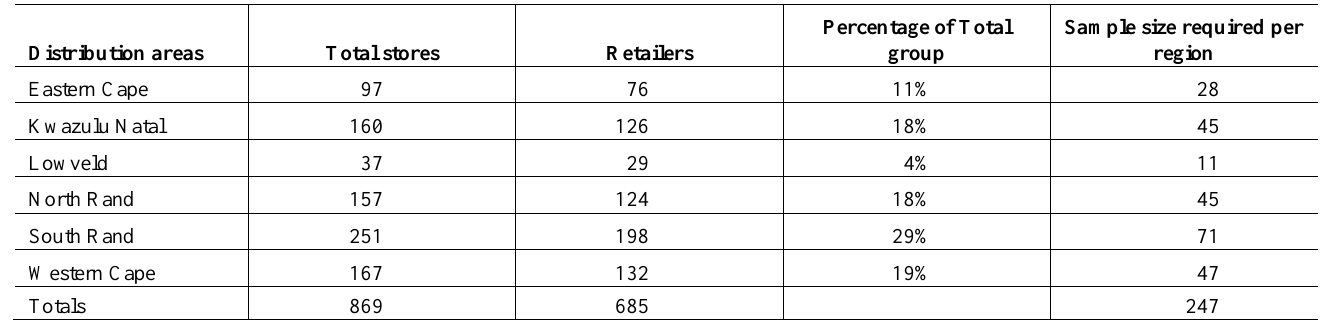
Table 3: Sample size required per region